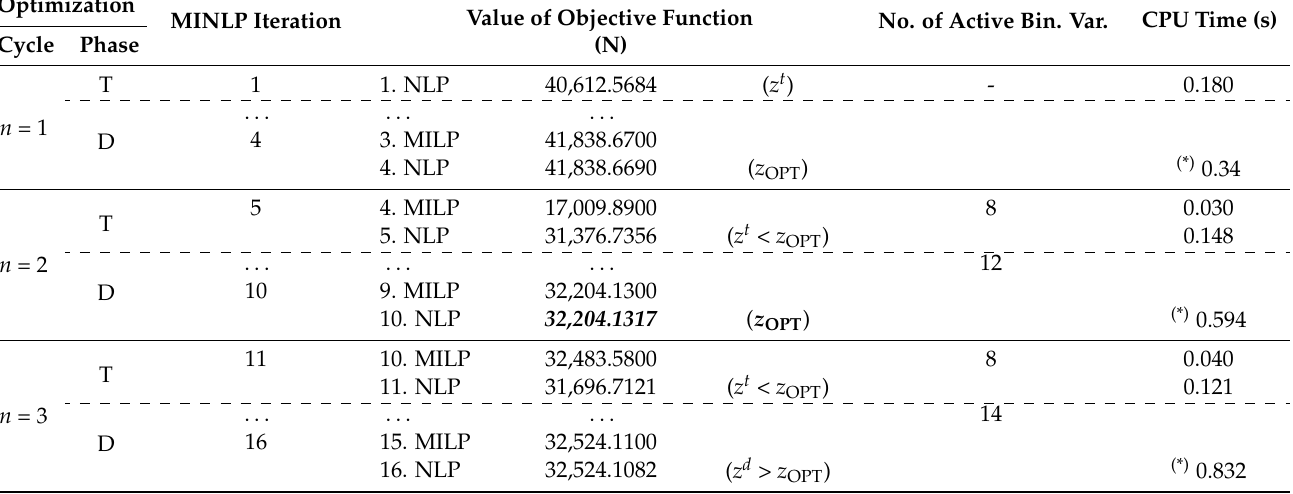
Table A2. Convergence of the Modified OA/ER algorithm and the STP strategy, example TC10c (topology optimization, with buckling